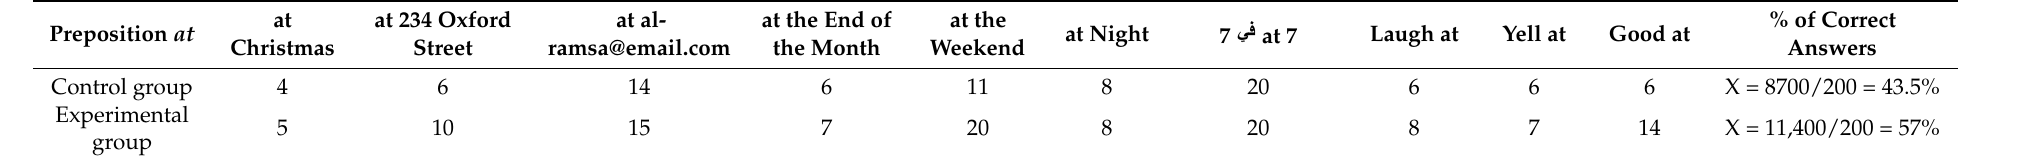
Table 8. Posttest 1 of the preposition at .